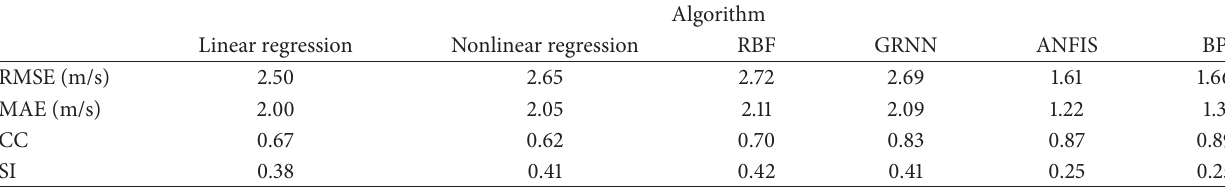
Table 1: Performance comparison of different algorithms.